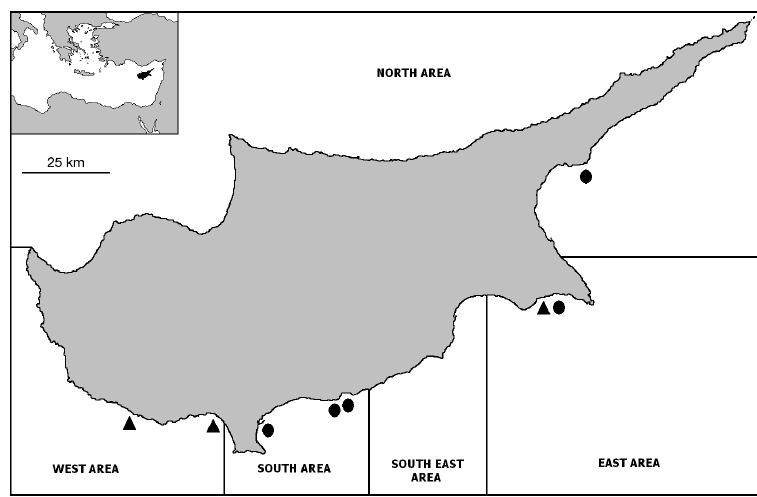
Fig. 1. Sampling areas around Cyprus and locations of aquaculture installations ( m hatchery site, d seacage